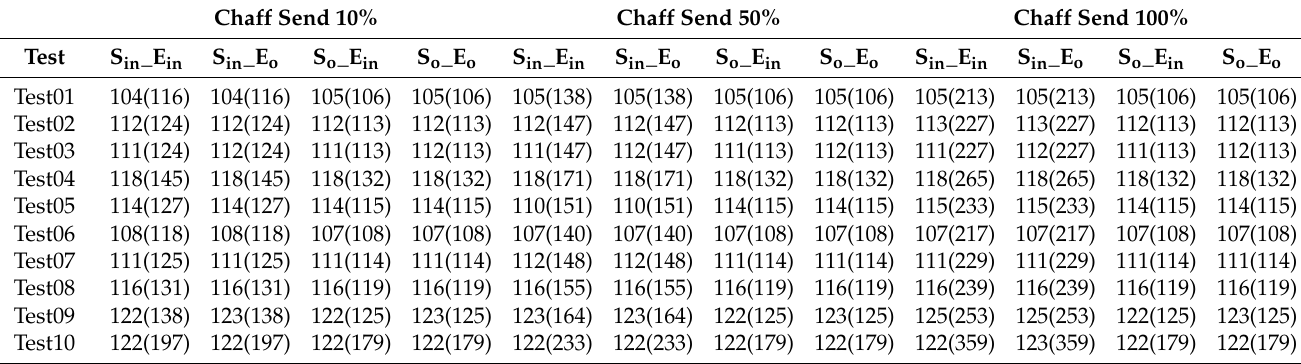
Table 3. Packet cross-matching results with Send chaffed rate 10%, 50%, and 100% at AWS1. Chaff Send 10% Chaff Send 50% Chaff Send 100%